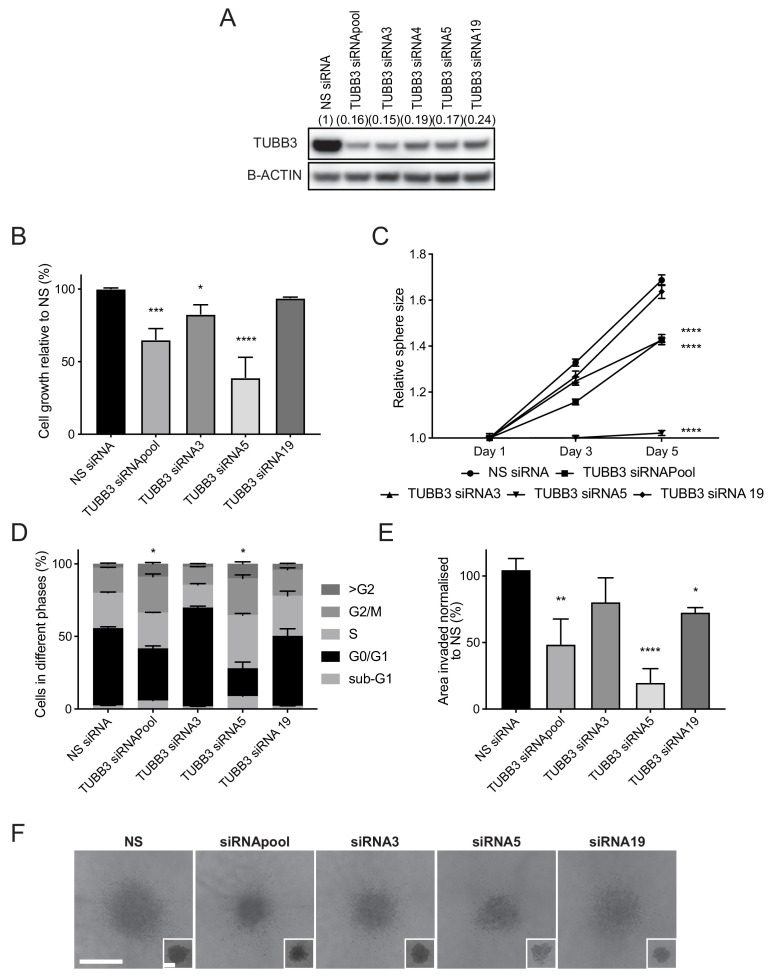
TUBB3, an established SOX11 target, regulates cell growth and invasive potential of ER- breast cancer cells.(A) Western blot of TUBB3 in total cell lysates of BT-20 cells transfected with siRNAs specific for TUBB3. B-ACTIN was used as loading control. Densitometry results normalised against NS siRNA are shown in brackets. (B) Cell growth assay results 5 days after BT-20 cells were transfected with siRNA specific for TUBB3 (since siRNAs require 48 hr for efficient knockdown). Results relative to NS siRNA are shown. Experiments performed three times. *p = 0.0297, ***p = 0.0001, ****p < 0.0001. (C) Sphere size measured 3 and 5 days after BT-20 cells were transfected with siRNA specific for TUBB3. Results relative to NS siRNA are shown. Experiments performed three times. ****p < 0.0001. (D) Cell cycle analysis performed by flow cytometry at day two after siRNA transfection specific for TUBB3 in BT-20 cells. Graph shows % of cell in each phase of the cell cycle. *p = 0.0396 (Phase G2/M siRNApool vs siRNA NS) and *p = 0.0243 (Phase G2/M siRNA5 vs siRNA NS). Experiments were performed three times. (E) Invasion assay after overlaying BT-20 spheroids with Collagen I at day 2 after siRNA transfection specific for TUBB3. Graph shows the area invaded in pixel2 normalised against NS siRNA. *p = 0.0444, **p = 0.0014, ****p < 0.0001. (F) Representative images of BT-20 spheroids transfected with indicated siRNAs to TUBB3 48 hr after adding Collagen I and (in small insets) at time 0 hr (2 days after transfection). Scale bar: 200 μm. NS: non-silencing.